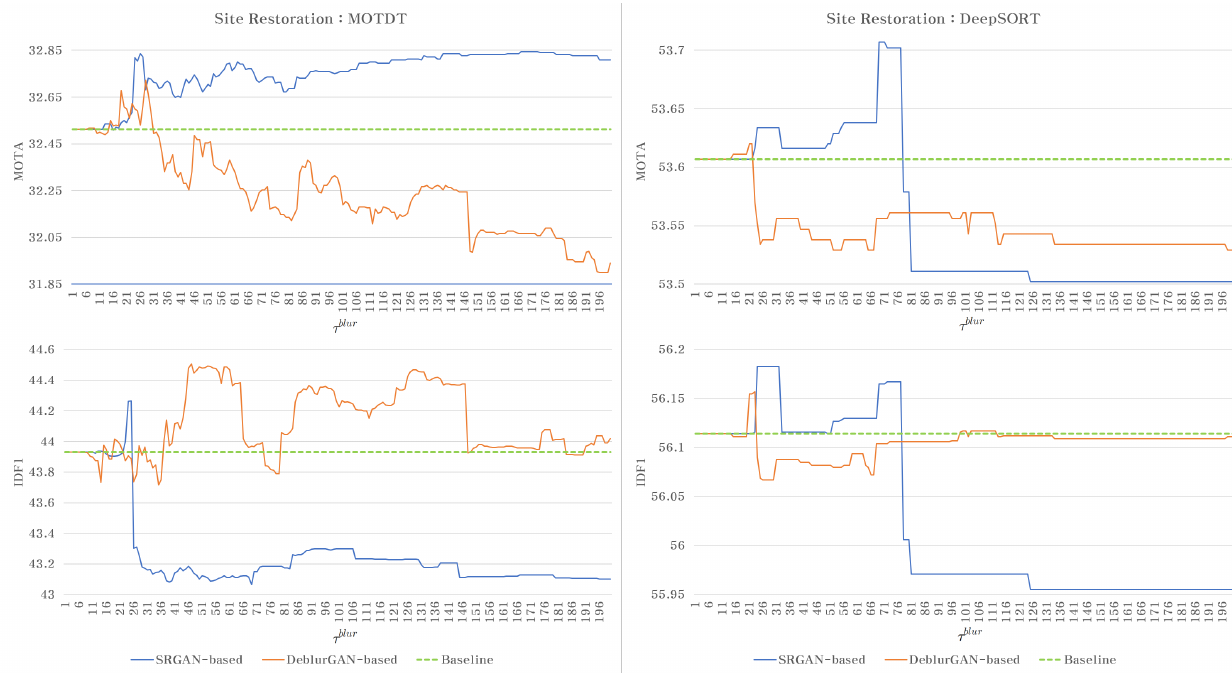
Figure 12. Experimental results to evaluate the effect of SRGAN- or DeblurGAN-based image restoration modules on the appearance model of the baseline tracker. The experiment proceeds with increasing τ blur by 1